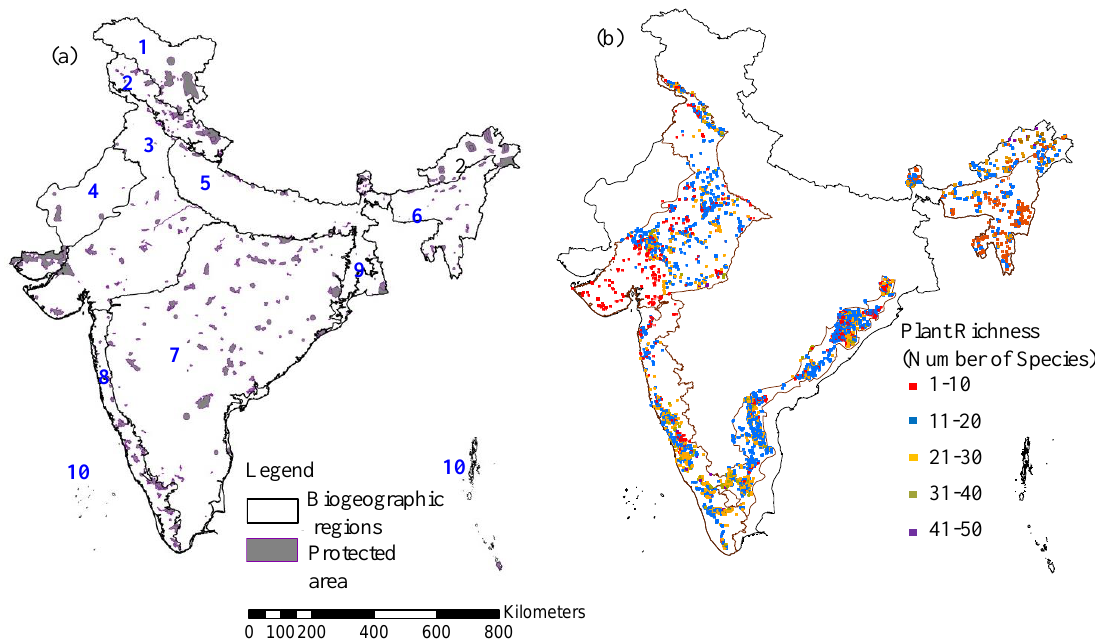
Figure 1. ( a ) Biogeographic regions of India where, 1-trans-Himalaya, 2-Himalaya, 3-semi-arid, 4-arid, 5-Gangetic plain, 6-Northeast, 7-Deccan peninsula, 8-Western Ghats, 9-Coasts, 10-Islands; and Protected Areas; ( b ) Spatial distribution of plant richness from 0.04 ha nested quadrats that ranged from 1 to 50 in four selected biogeographic regions of India (semi-arid, eastern Ghats, Western Ghats, and Northeast) for this study.